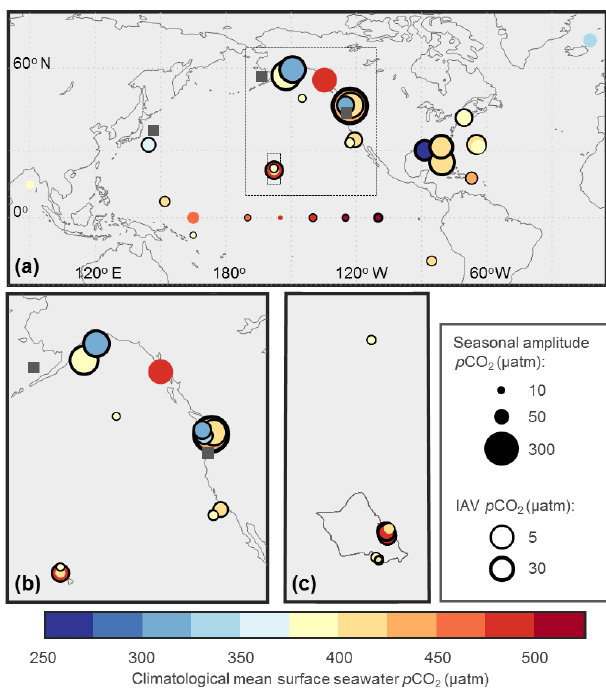
Figure 1. Location of (a) 40 moored p CO 2 time series with insets enlarged for the (b) US west coast and (c) Hawaiian island of Oahu. Circle color represents climatological mean seawater p CO 2 (µatm), size of circle represents seasonal amplitude, and thickness of cir- cle outline represents interannual variability (IAV). Gray squares show the locations of JKEO, M2, and NH-10 where insufficient winter observations prevent the calculation of climatological mean or seasonal amplitude. The IAV is not shown for sites with less than 3 years of observations (Kaneohe, Iceland, BOBOA, SEAK, M2, SOFS, BTM, TAO165E, TAO155W, NH-10, and JKEO). Dabob and Twanoh data shown here are x CO 2 (µmolmol − 1 ). Moored time series locations and names are detailed in Table